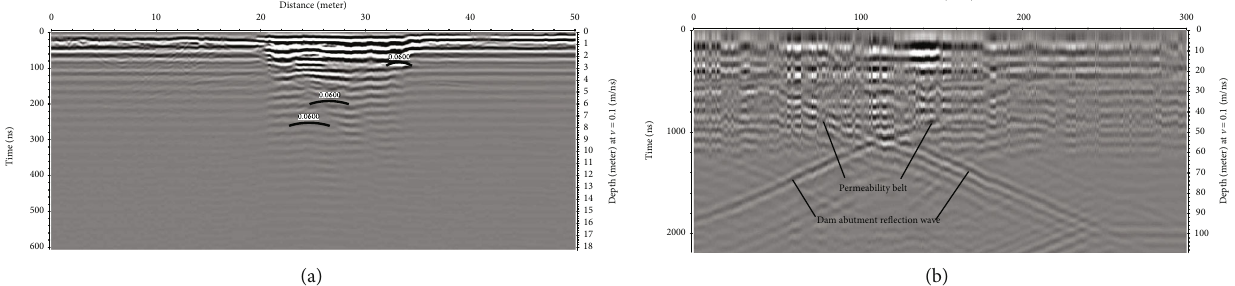
Figure 17: Gray chart of radar test of grouting adit on the right bank (a) and gray map of ground penetrating radar test for bedrock of dam foundation